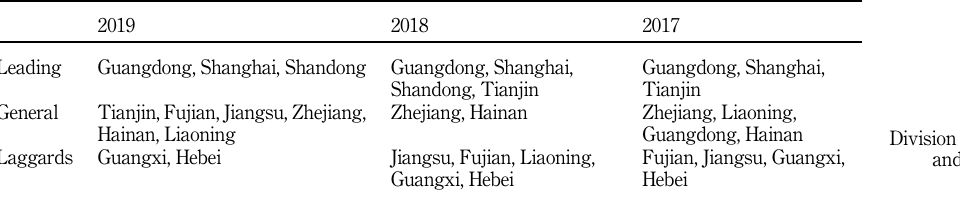
Table 9. Division of